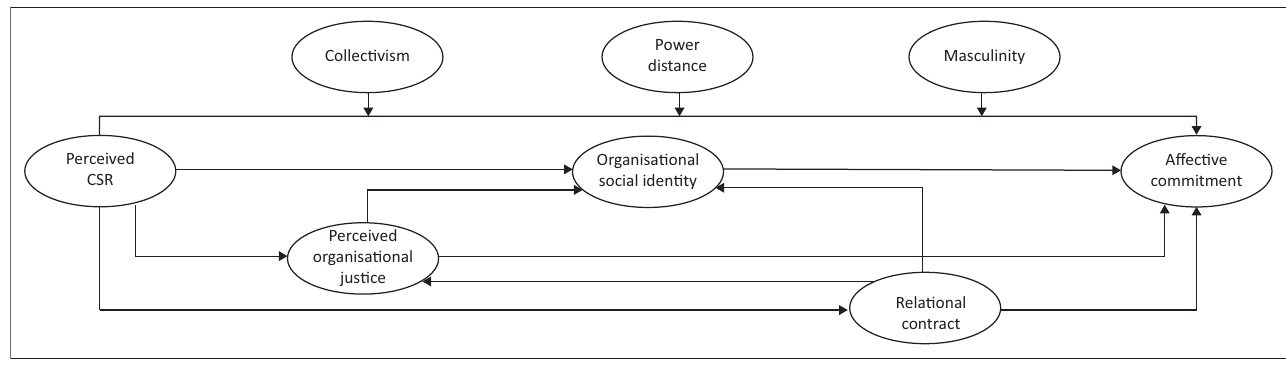
FIGURE 1: Structural model representing the hypothesised relationships between the selected constructs.